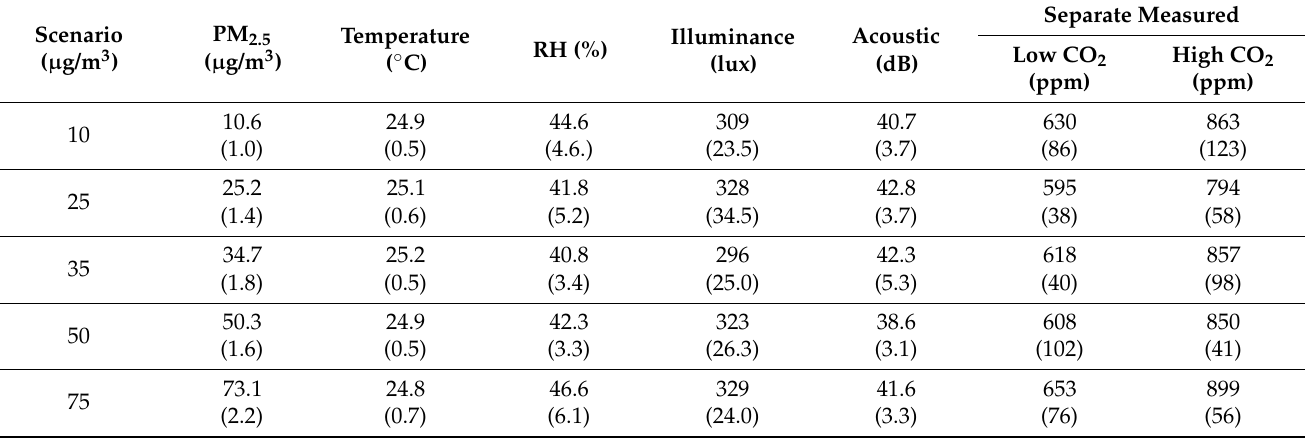
Table 6. Measured indoor environment parameter at the center of the desk.